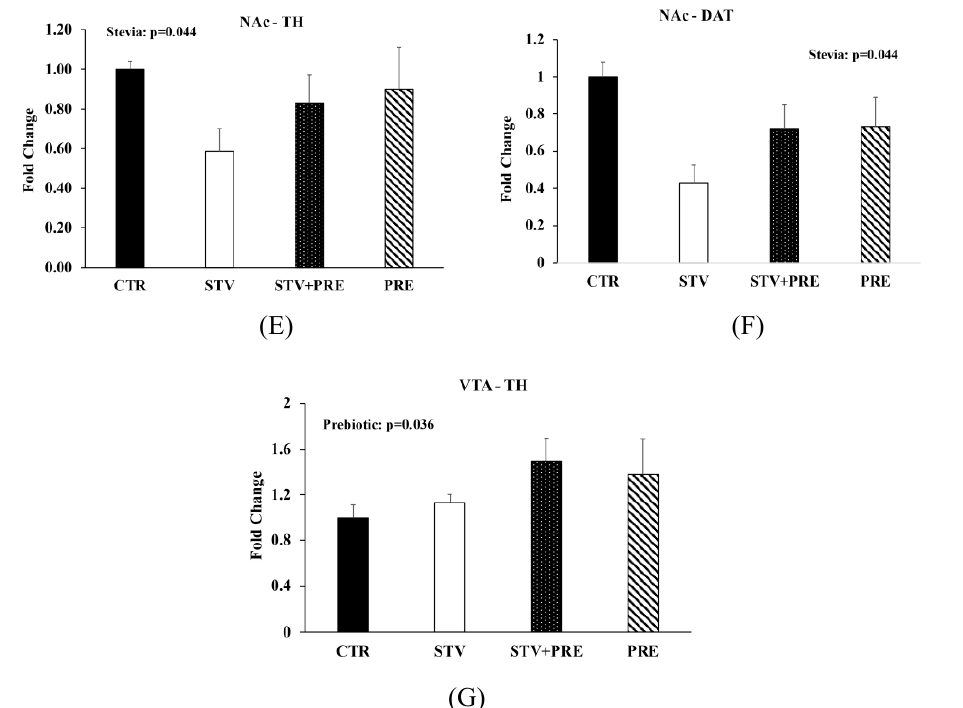
Figure 3. Insulin and glucose tolerance tests, intestinal permeability, and gene expression in the brain of male rats consuming RebA, prebiotics, both or neither for 9 weeks. ( A ) Insulin tolerance test; ( B ) oral glucose tolerance test; ( C ) oral glucose tolerance test area under the curve (AUC); ( D ) gut permeability (FITC) test; ( E ) nucleus accumbens tyrosine hydroxylase mRNA levels; ( F ) nucleus accumbens dopamine transporter mRNA levels; ( G ) ventral tegmental area tyrosine hydroxylase mRNA levels. Values are mean ± SEM, n = 8 / group. Labelled means without a common superscript letter (a, b, c) differ, p < 0.05. CTR, control; STV, RebA; STV + PRE, RebA and prebiotic; PRE, prebiotic; AUC, area under the curve; FITC, fluorescein isothiocyanate–dextran-4000; NAc-TH, nucleus accumbens tyrosine hydroxylase; NAc-DAT, nucleus accumbens dopamine transporter; VTA-TH, ventral tegmental area tyrosine hydroxylase.